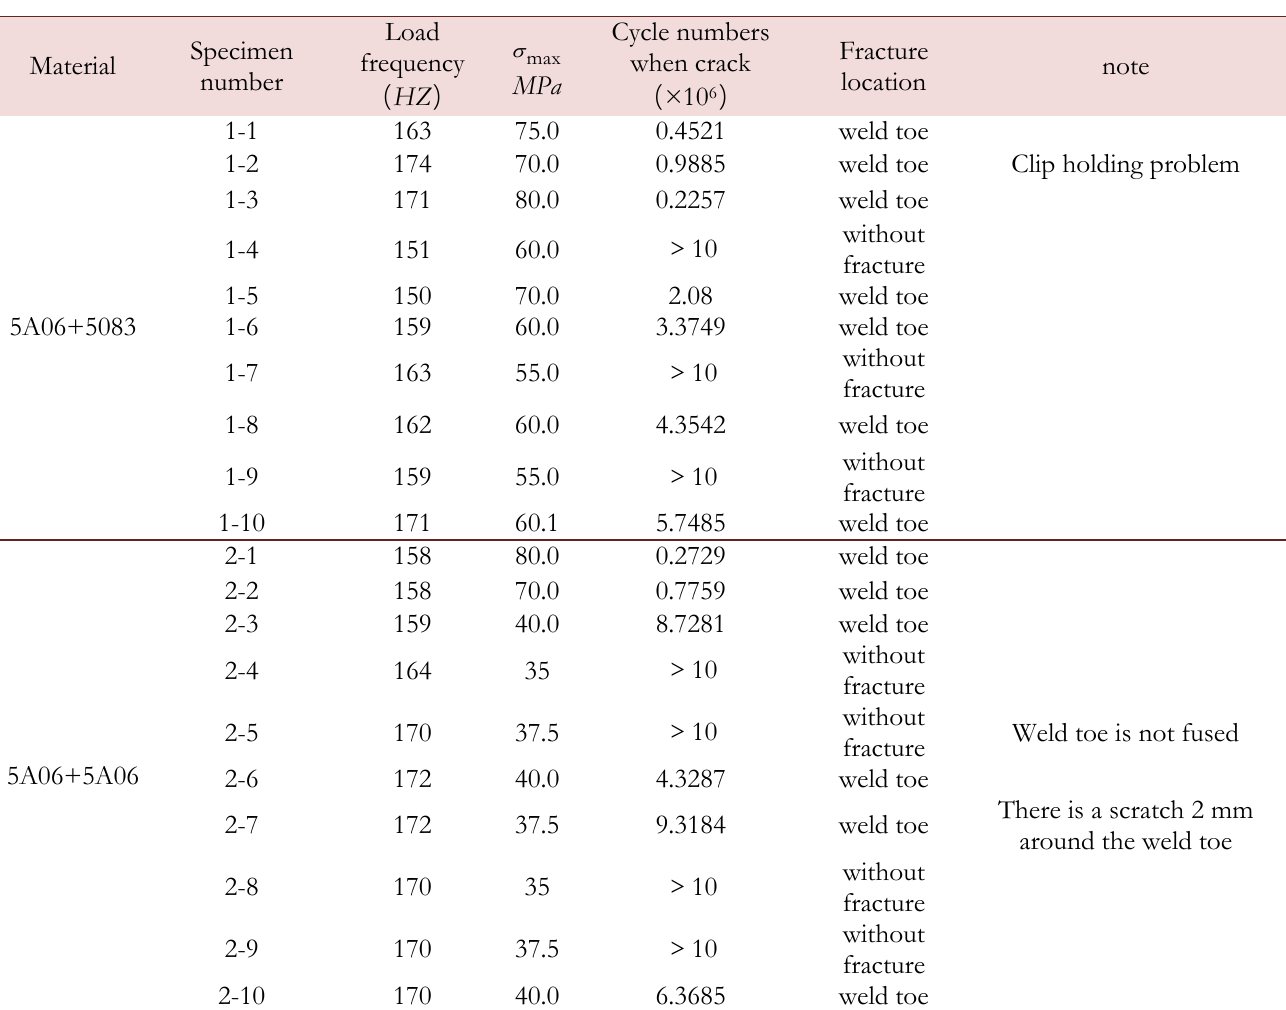
Table 6: Three-point bending fatigue test data of